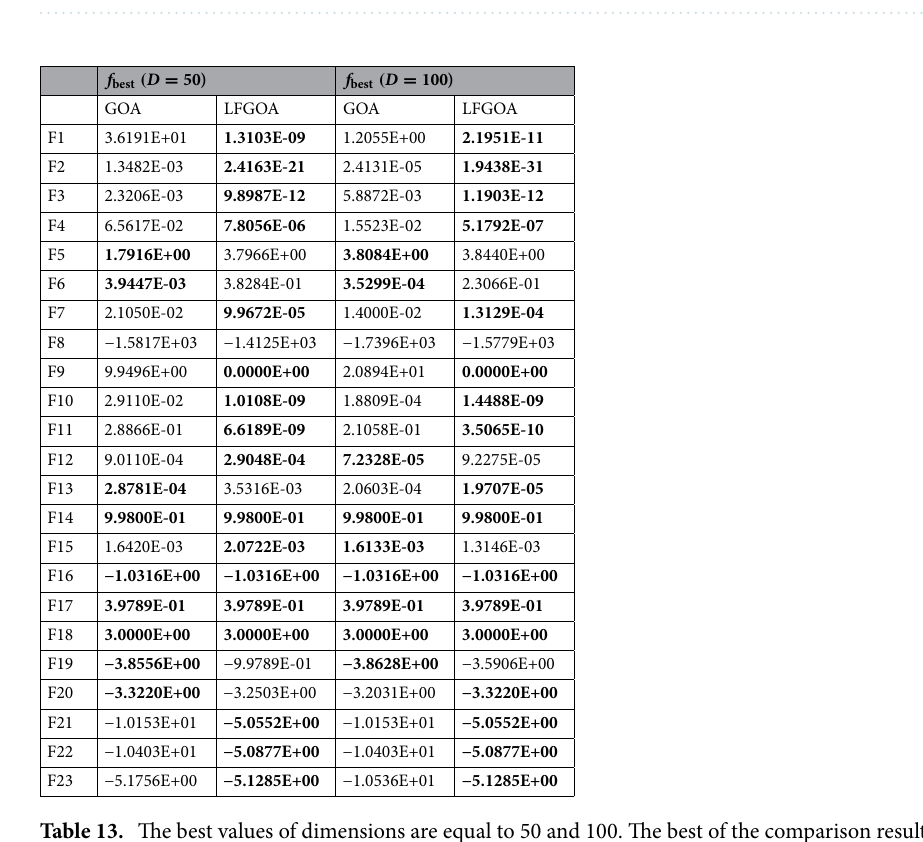
Table 13. The best values of dimensions are equal to 50 and 100. The best of the comparison results are in [bold].